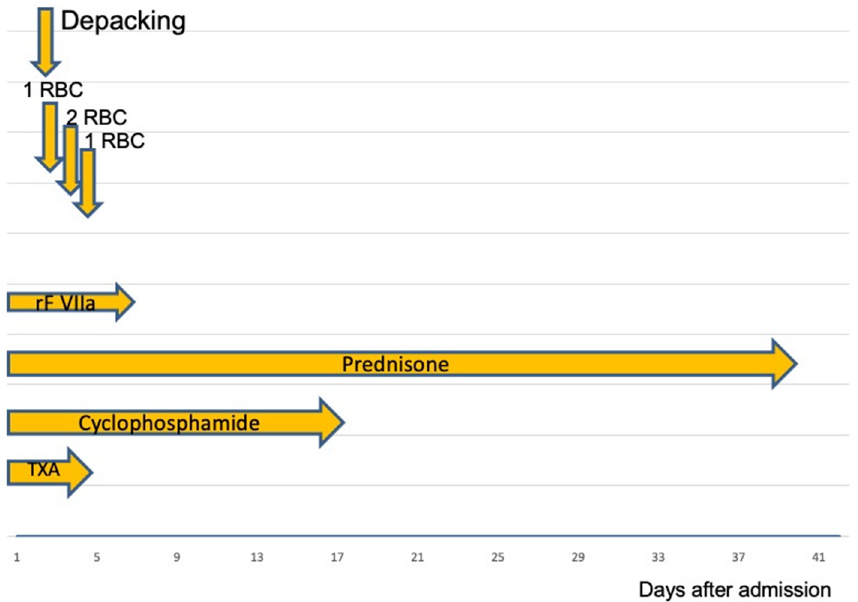
Figure 2. RBC: packed Red Blood Cells; rFVIIa: recombinant Factor VIIa, TXA: Tranexamic acid. After successful coagulation management, the bleeding was stopped. On the second admission day, abdominal packs were removed. During the initial 4 days, the patient received a total of four units of RBCs. Following surgery, the dose of rFVIIa was reduced and then stopped after 3 days.